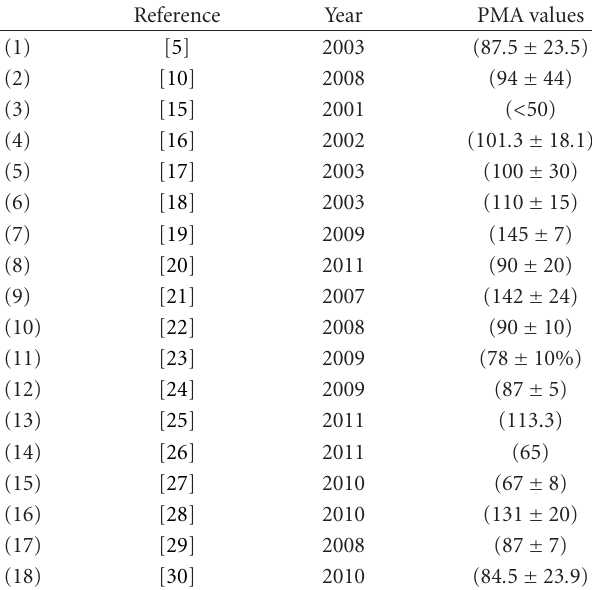
Table 3: Predicted maximum amplitude (PMA) for solar cycle 24 as they were